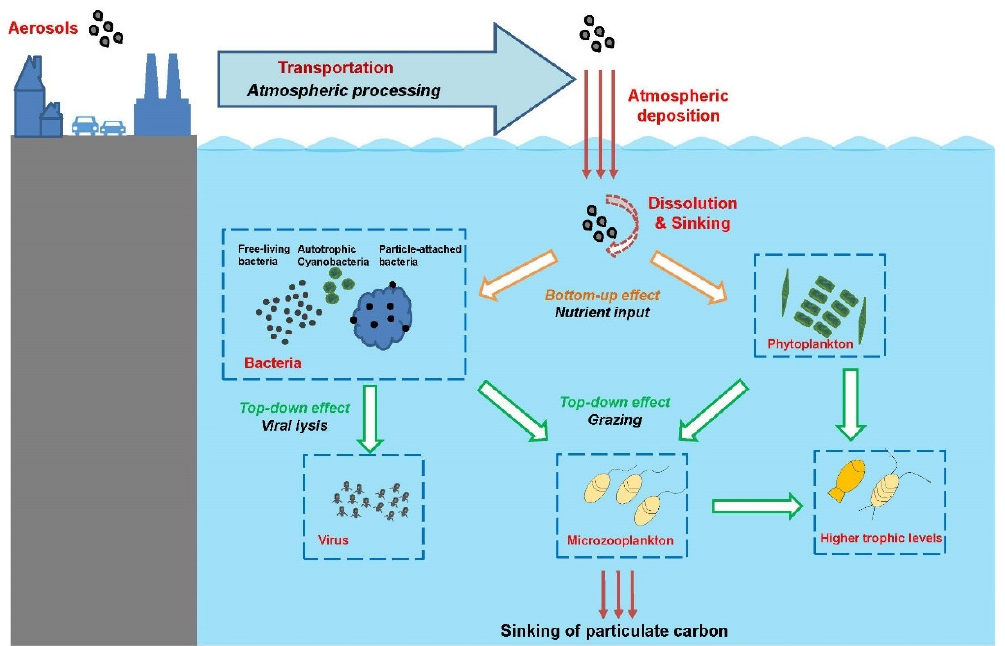
Figure 1. Impacts of aerosol deposition on the marine food web. Aerosols from natural and anthro- pogenic sources are transported to ocean regions. The solubility of nutrients in the aerosols can be enhanced by atmospheric processes such as acidification, photochemical, or cloud processes before being deposited to the seawater. In the ocean, the dissolved aerosol nutrients can be cycled through microbial food web, influencing microbial metabolism, community composition, and biogeochemical cycles, and/or sink in the deep ocean.